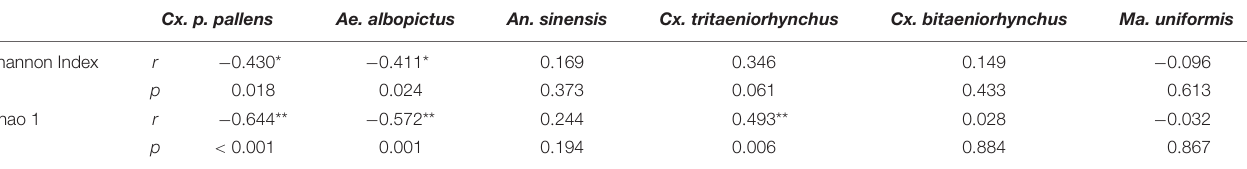
TABLE 6 | Pearson correlation coefficient between larval density and bacterial diversity of larval